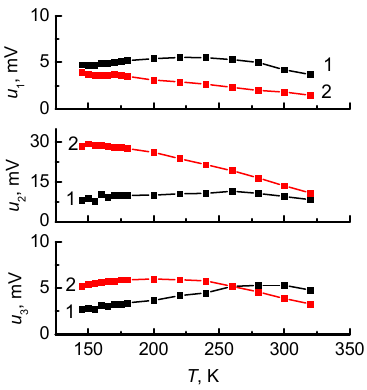
Figure 15. Temperature dependences of amplitudes of three harmonics of the ME signal for the LGT- Metglas structure at H = 4 Oe. Curve 1: h 0 = 5 Oe; Curve 2: h 0 = 15 Oe.